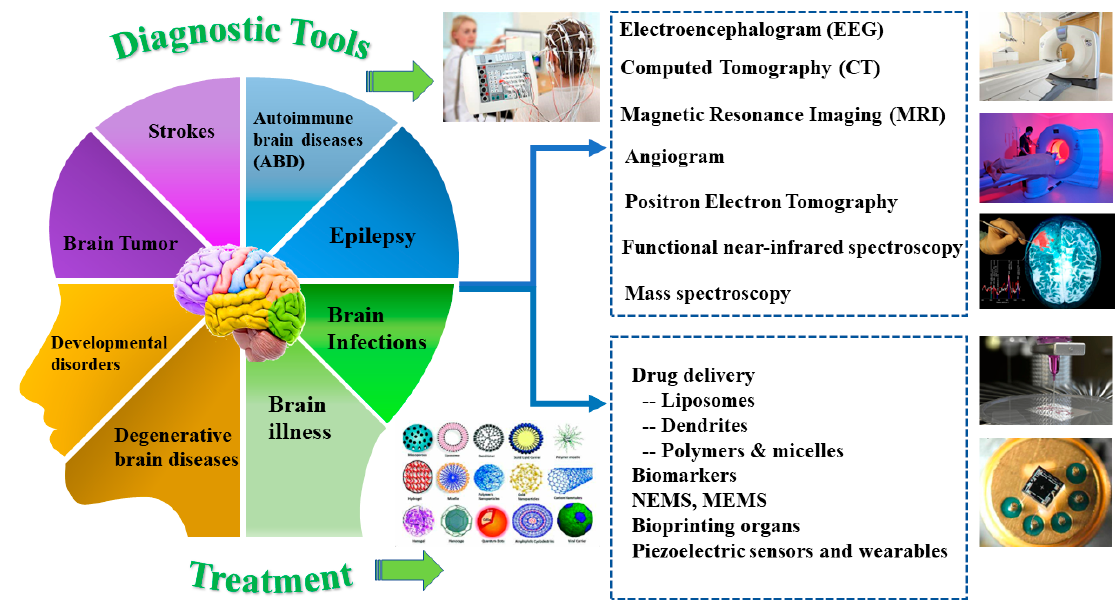
Figure 1. Schematic overview of the review, where the common brain diseases namely, Autoimmune brain diseases, Epilepsy, Brain infections, Brain illness, Neurodegenerative, Neurodevelopmental disorders, brain tumour and strokes, followed by the advancements in the diagnostic tools and treatment approaches highlighting the use of 5G technology, Artificial Intelligence, nanotechnology, self-powered wearables, and microelectromechanical